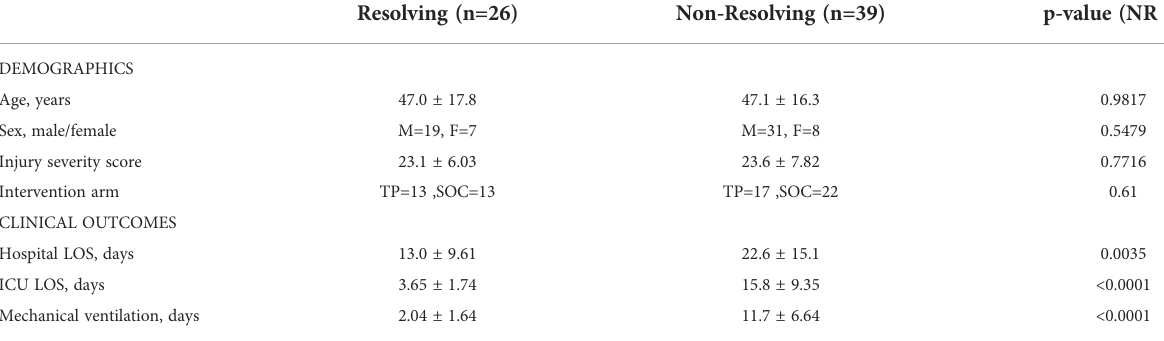
TABLE 2 Demographic data and clinical outcomes of patient groups after matching for